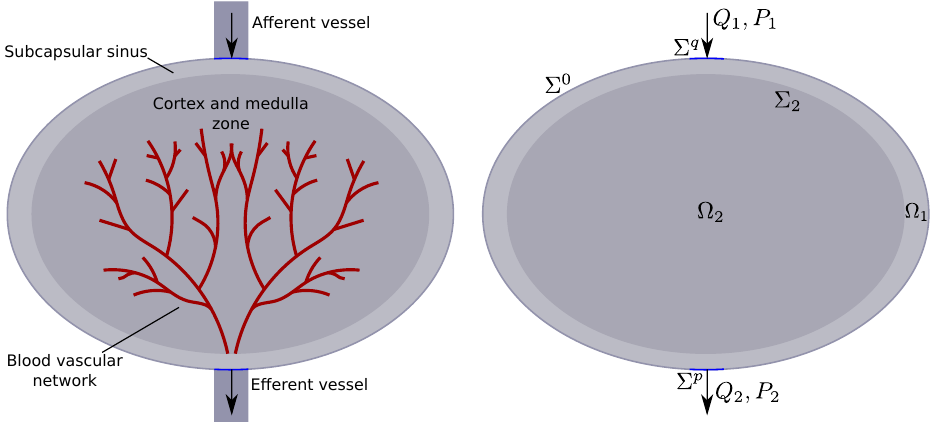
Figure 1. Simplified schematic representation of the lymph nodes: an external subdomain with low hydraulic resistance and an internal subdomain where lymph is absorbed into the blood